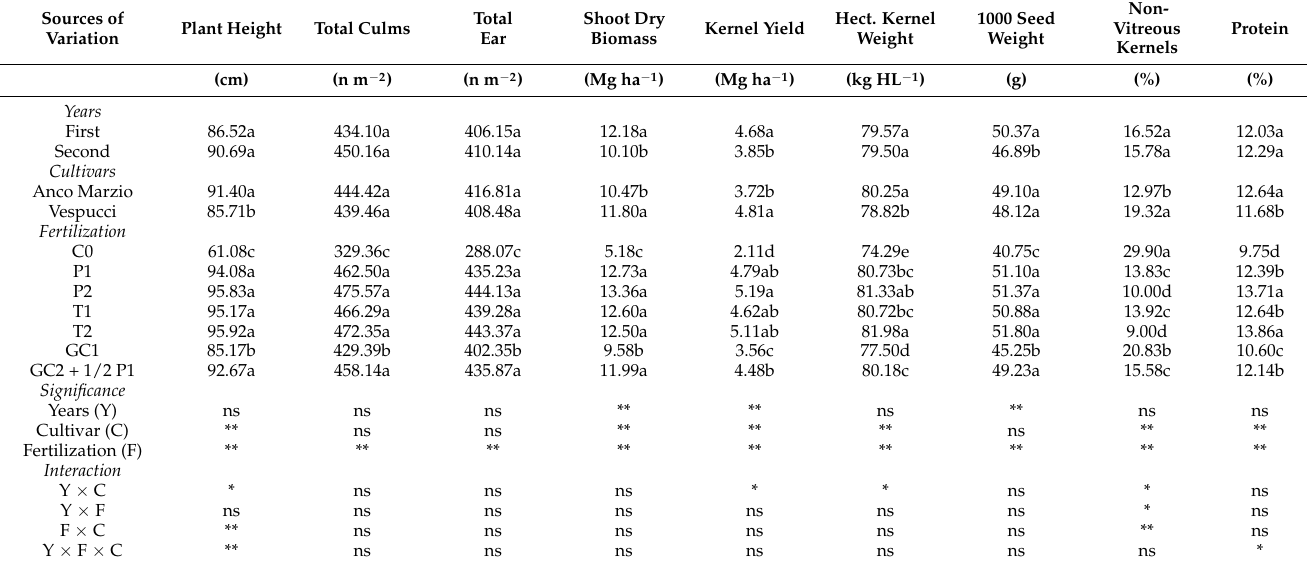
Figure 4. Mean SPAD values observed at the following crop stages: stem elongation, booting, ear emergence, and kernel ripening phases in two durum wheat cultivars (Anco Marzio and Vespucci) grown under different fertilization regime during the first and second year. For each effect considered, the values followed by the same letter are not significantly different, according to the SNK test at p = 0.01.